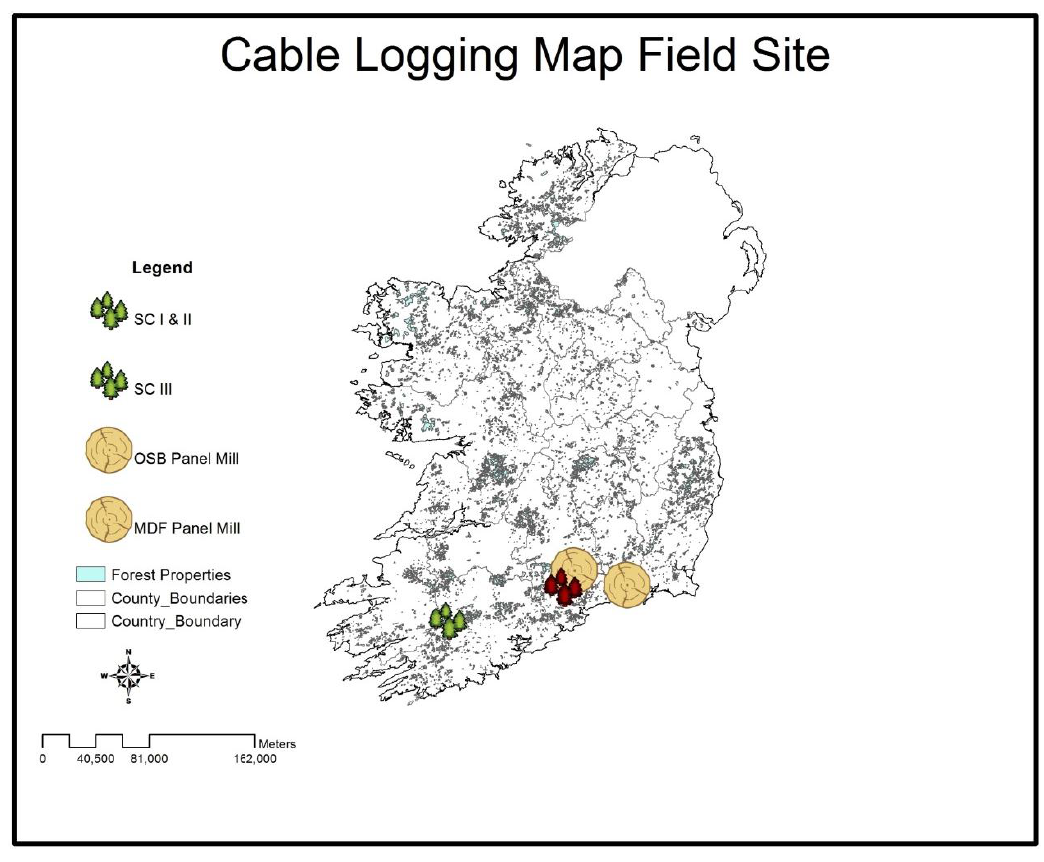
Figure 3. JCB Excavator based cable logging whole tree system near Macroom, Co. Cork with harvester on landing (SCs I &